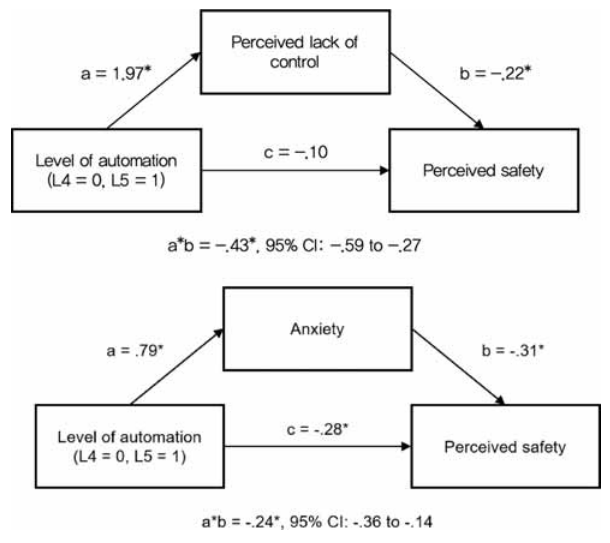
Fig. 2. Bootstrapping Analyses for Mediation in Study 2. (Note: * p < .05, signi fi cance levels are